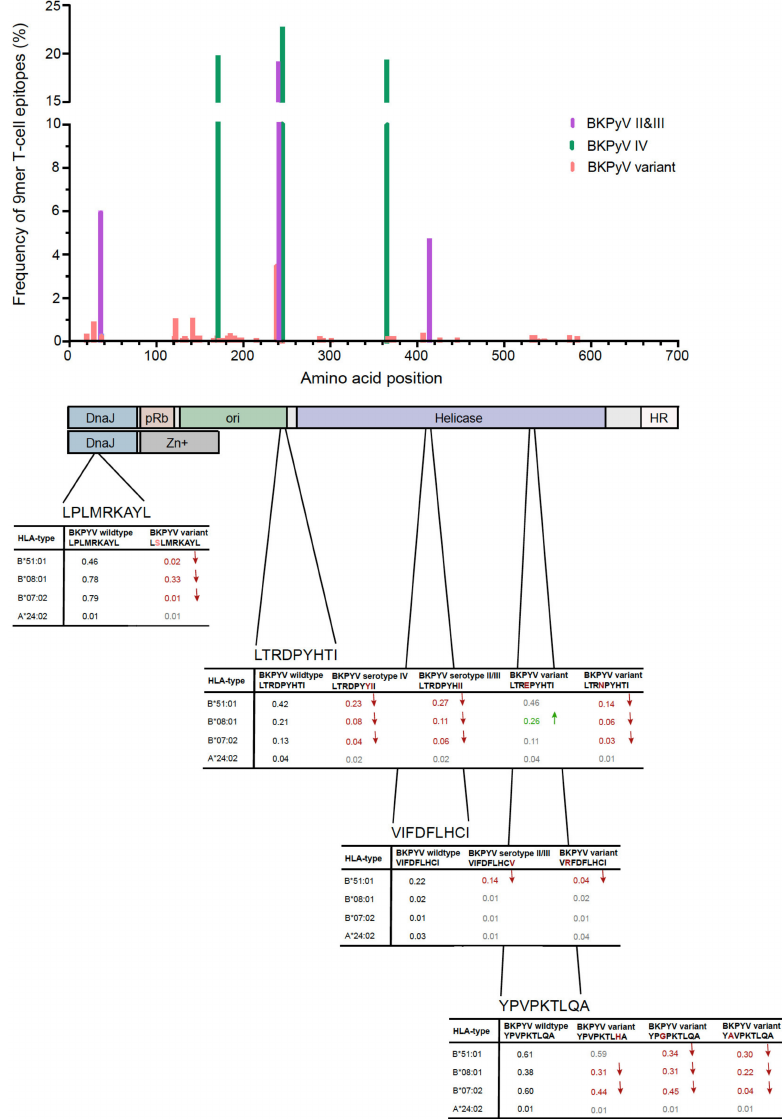
Figure 4. BKPyV-genotype independent amino acid exchanges in immunodominant LTag-9mer T-cell epitopes on HLA-A and HLA-B binding. The indicated BKPyV variant sequences occurred in previously reported LTag-9mer T-cell epitopes [34,37]. HLA binding was predicted using the Immune Epitope Database and Analysis Resource tool (red ↓ indicates a significant decrease in binding of at least 0.05; green ↑ indicates a significant increase in binding of at least 0.05). Schematic drawing of the respective domains in LTag and small T antigen (sTag; according to DeCaprio and Garcea [44]) are indicated below the diagram (DnaJ homology region (DnaJ), retinoblastoma protein binding domain (pRb), origin of DNA replication binding domain (ori), host range domain (HR)). Of note, the amino-terminal part including the DnaJ homology domain is identical for sTag and LTag, whereas the carboxyterminal domains indicated are specific for sTag or